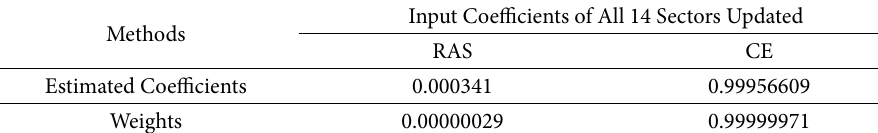
Table 3. Estimated coefficients and optimal weights for 14 sectors